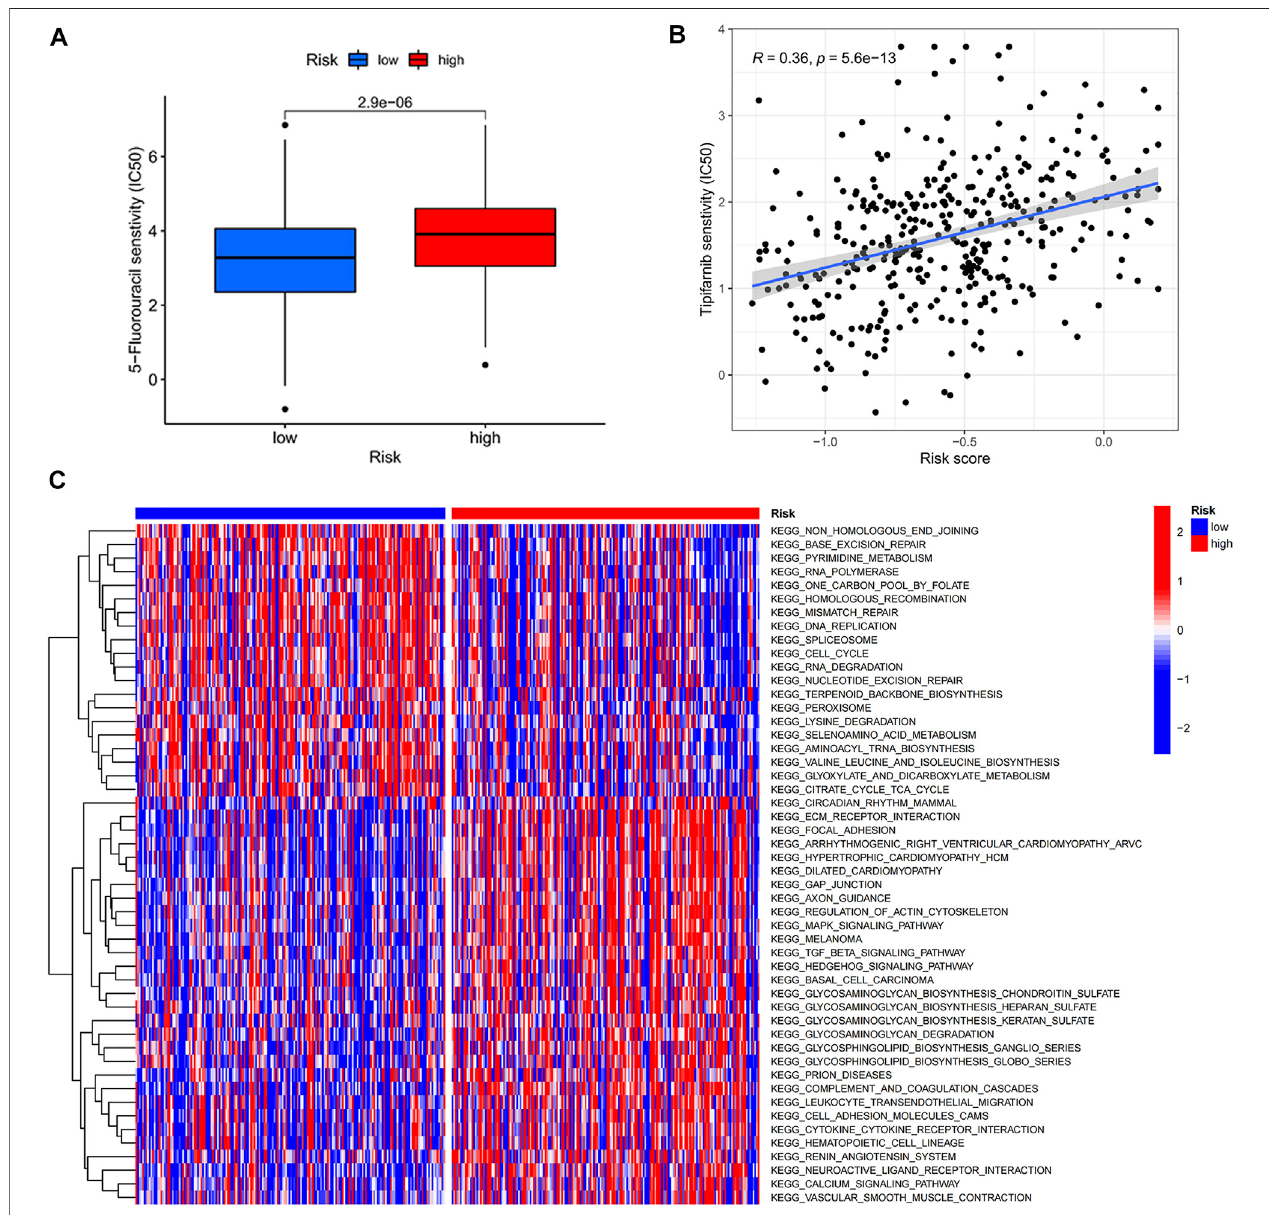
FIGURE 5 | Risk score-guided chemotherapy. (A) Box plot of IC 50 differential analysis for high- and low-risk score groups. (B) Scatter plot of correlation between risk score and IC 50 . (C) Heat map of the differential analysis of GSVA enrichment between high- and low-risk groups.